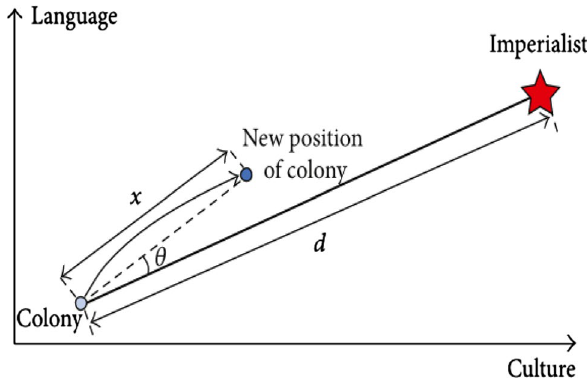
Fig. 5 Moving the colony toward the relevant imperialist in a ran- domly deviated route (Khalili et al. 2016) Fig. 6 a Exchanging the positions of a colony and the imperialist, b the entire empire after position exchange (Khalili et al.